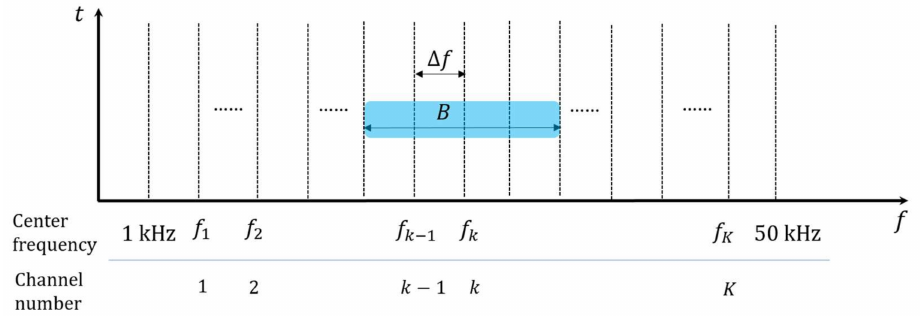
Figure 2. The illustration of the frequency grid in the available acoustic frequency